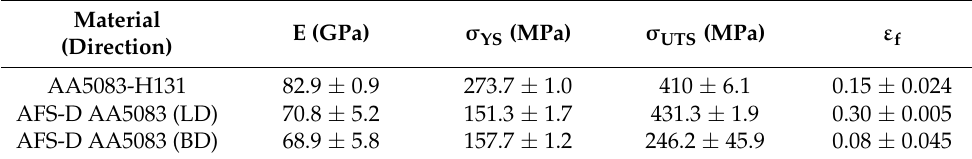
Figure 5. ( A ). Profile view of AFS-D AA5083 deposit. ( B ) Comparative tensile stress-strain response of the wrought AA5083-H131 feedstock and as-deposited AA5083. ( C ) Top view of AFS-D AA5083 deposit. ( D ). Sample geometry used in this study. Table 3. Summary of AA5083-H131 feedstock and as-deposited AFS-D